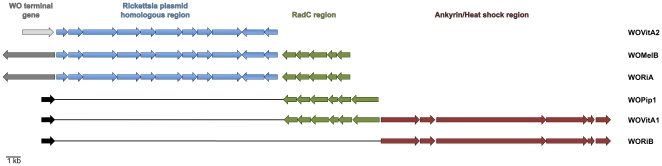
WO flanking regions contain conserved gene sets.The prophages WOVitA2, WOMelB, and WORiA are flanked on one end by a segment of genes that is conserved on a Rickettsial plasmid [36] (blue). In WOMelB and WORiA, a second conserved gene set (green), comprised of transcriptional regulators and the DNA repair gene radC, is found downstream of the Rickettsia gene homologs. This region is the prophage-flanking region in WOPip1 and WOVitA1. A third conserved gene segment (red) of ankyrin repeat proteins, a heat shock protein, and a conserved hypothetical protein, is found in WOVitA1 and flanking the prophage terminal gene in WORiB. Light gray: RepA; Dark gray: SNF2-family helicase; Black: patatin.